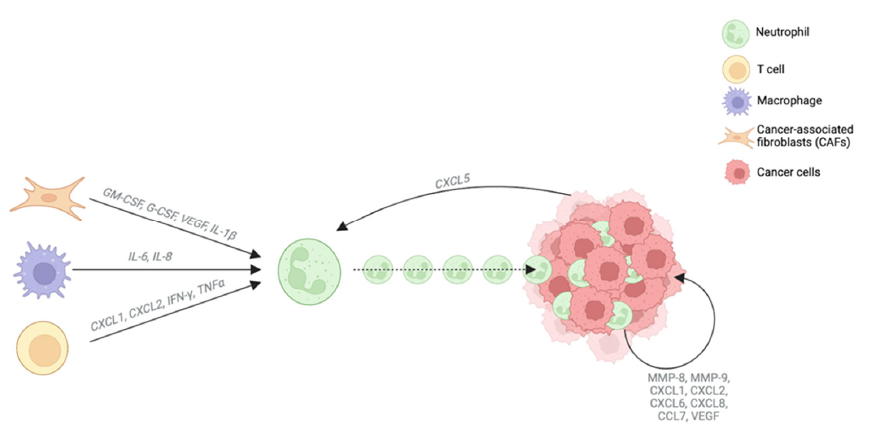
Figure 4. Neutrophil recruitment to the tumor site. TAN are recruited to the tumor site by interaction with different molecules produced by other cell types such as GM ‐ CSF, granulocyte colony ‐ stimulating factor (G ‐ CSF), VEGF and IL ‐ 1 β produced by CAFs; IL ‐ 6 and IL ‐ 8 produced by TAMs; and CXCL1, CXCL2, IFN ‐γ and TNF ‐α produced by T cells. Moreover, cancer cells also recruit neutrophils to the tumor site by releasing CXCL5. Once they reach the tumor site, TAN release different factors described to be highly involved in CCA biology such as MMP ‐ 8, MMP ‐ 9, CXCL1, CXCL2, CXCL6, CXCL8, CCL7 and VEGF.